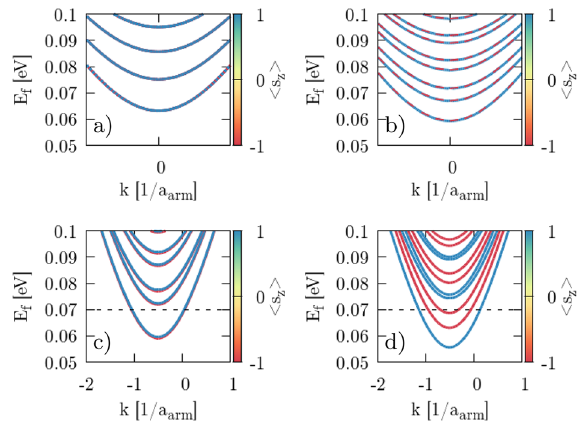
0 ( a , b ) z = 0.07 eV. The color bar indicates the F = 3 a s is the zigzag lattice constant. =